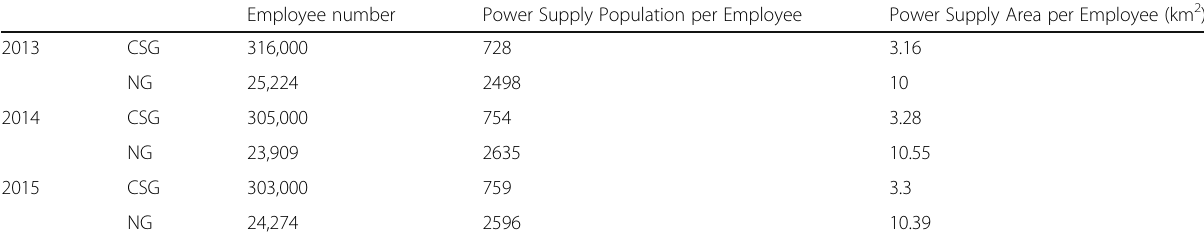
Table 3 Power supply area of CSG and NG in 2013 – 2015 Employee